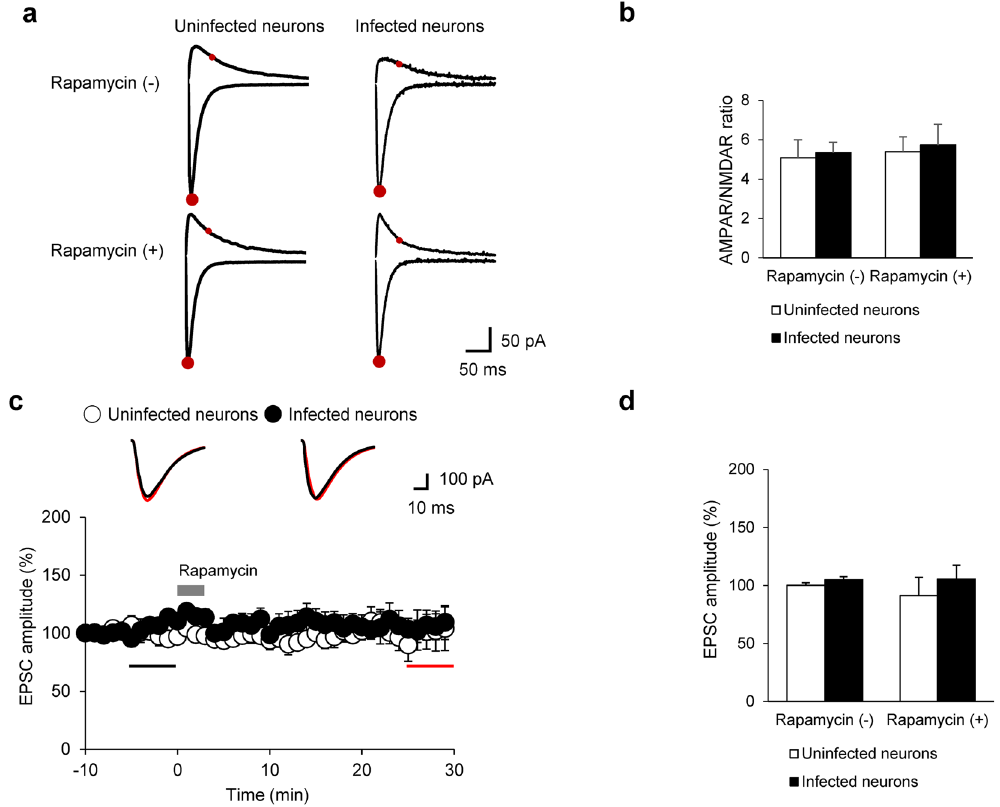
Figure 4. Lack of effect of rapamycin or acute reduction of PIP 2 on excitatory synaptic transmission. ( a ) Representative traces of evoked EPSCs ( − 70 mV holding potential for AMPAR-EPSCs and + 40 mV holding potential for NMDAR-EPSCs). AMPAR- (lower large red circles) and NMDAR-dependent EPSCs (upper small red circles) were measured. ( b ) Mean AMPAR/NMDAR ratios for each group (Rapamycin ( − ): uninfected 5.08 ± 0.92, N = 7, n = 11 vs . infected 5.34 ± 0.76, N = 5, n = 7, p > 0.1; Rapamycin ( + ): uninfected 5.39 ± 0.53, N = 6, n = 12 vs . infected 5.73 ± 1.06, N = 5, n = 6, p > 0.1, Mann-Whitney U-test). ( c ) Time course of the normalized amplitudes of EPSCs in hippocampus CA1 neurons. Amplitudes of EPSCs are normalized to baseline levels that were recorded for 10 min before treatment with rapamycin (gray bar). Inserts: representative traces with color- matched time points. ( d ) Mean EPSC amplitudes in CA1 neurons for each group. (Rapamycin ( − ): uninfected 100.23 ± 2.17%, N = 4, n = 5 vs . infected 104.93 ± 2.58%, N = 4, n = 4, p > 0.1; Rapamycin ( + ): uninfected 91.28 ± 15.68%, N = 4, n = 5 vs . infected 105.42 ± 12.13%, N = 4, n = 4, p > 0.1, Mann-Whitney U-test). Error bars show mean ±